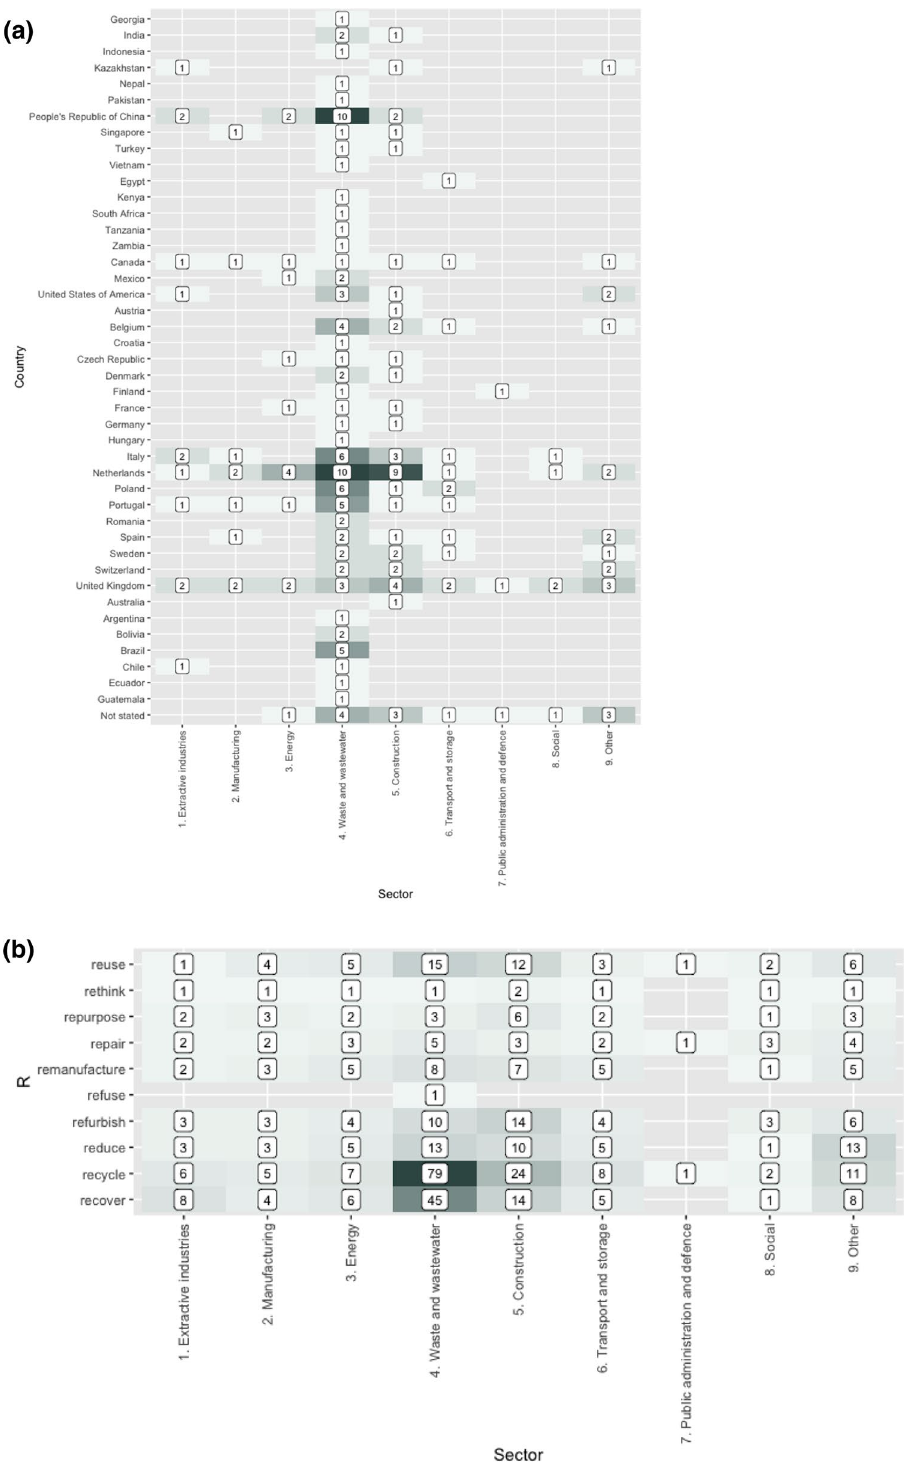
Fig. 7 Heat maps: a the num- ber of included articles across countries and sector; b the number of included articles across ‘R’ and sector; c the number of included articles across countries and